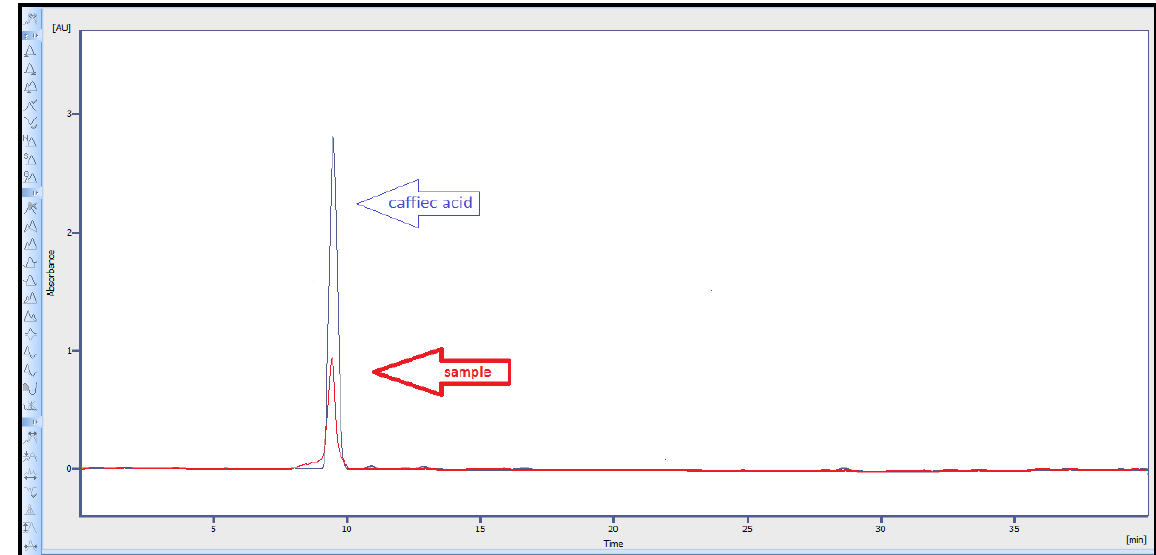
Figure 18. HPLC chromatogram of Caffeic acid standard and isolatedi compound number 3 .